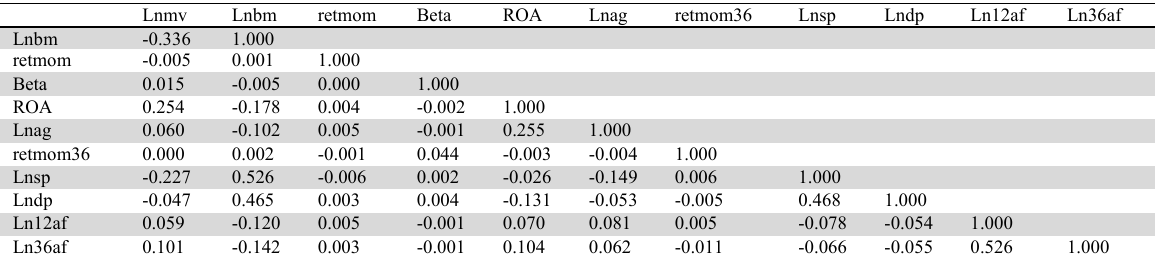
Pearson Correlation Matrix